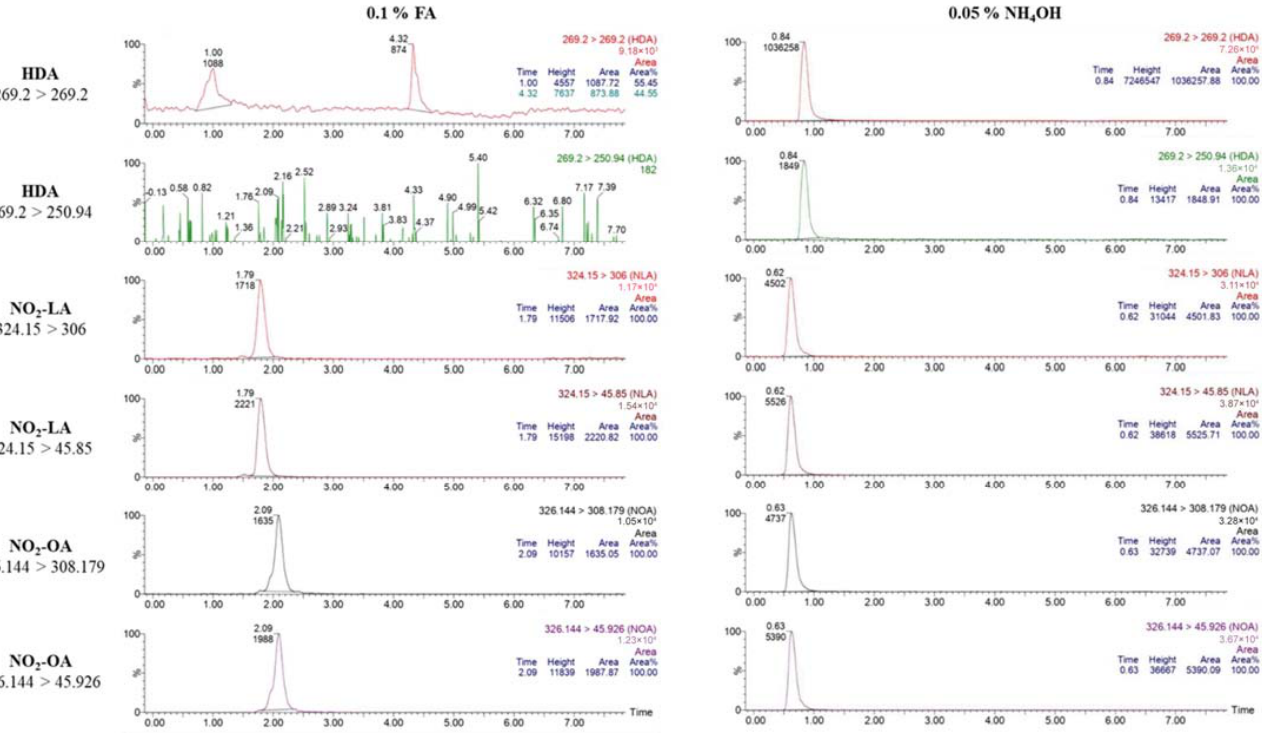
Figure 5. Retention and sensitivity of NO 2 -OA, NO 2 -LA and HDA on reversed phase UPLC-MS/MS using acidic ( right ) and basic ( left ) mobile phase additives.